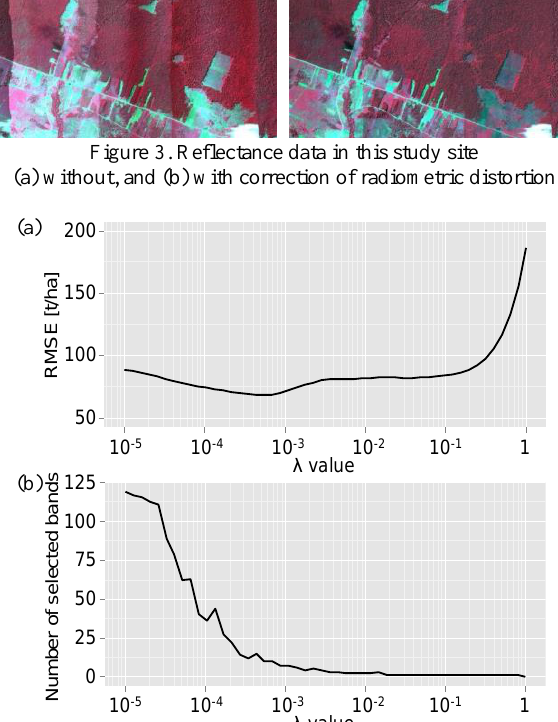
Figure 4. Comparison of the results in lasso regression (a) effect of lambda on the overall prediction accuracy, (b) the number of selected bands in each lambda value